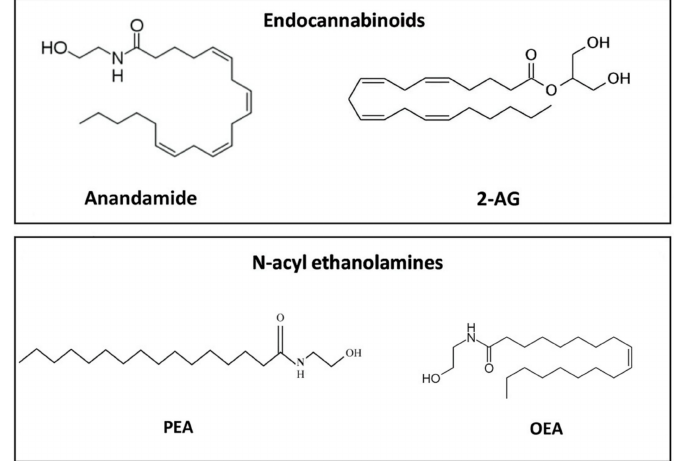
Figure 1. Chemical structure of representative endocannabinoids and related